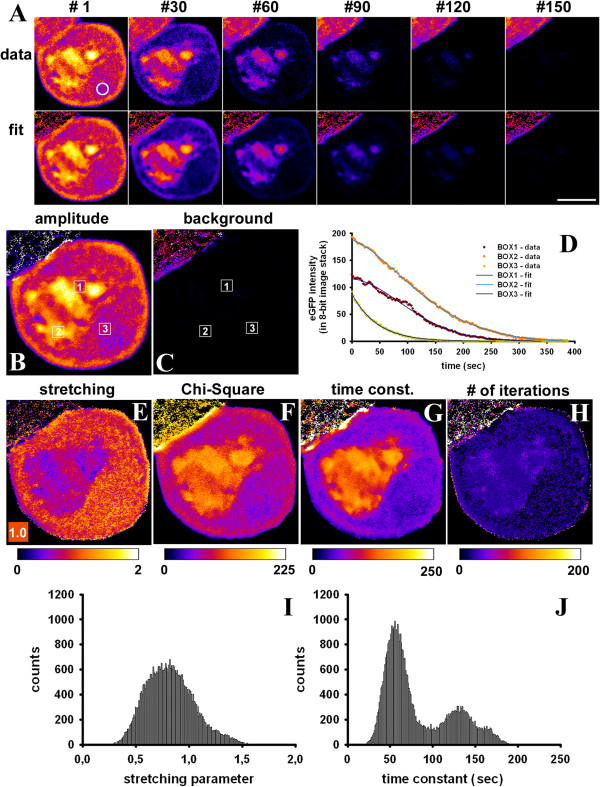
Barrier-limited FLIP of eGFP shuttling between nucleus and cytoplasm. McArdle RH7777 cells expressing eGFP in the cytoplasm and nucleus were placed on a temperature-controlled stage of a confocal microscope maintained at 35 ± 1°C. A 30 pixel diameter circular region in the cytoplasm (white circle) was repeatedly bleached with full laser power, while the whole field was scanned with 0.5% laser output between the bleach scans such that the total frame rate was 2.6 sec. A montage of every 30th frame of the data (upper panel, ‘data’) or of the reconstruction from a pixel-wise fit of data to the StrExp function (lower panel, ‘fit’). B, amplitude map; C, background map, each with three boxes numbered 1 to 3. D, FL in these three boxes along the stack (colored symbols) + fit to StrExp function (colored lines). E-H, parameter maps produced by PixBleach for: E, the stretching parameter (see Eq. 1; the color code for h = 1, the mono-exponential case, is given in small box); F, χ2-values showing the quality of the regression; G, time constant map; H, number of iterations. All values are color-coded using a FIRE-LUT, and the range is given below the images with a color bar. The time constant is given in seconds; all other values are without units. I, J; histograms of the stretching parameters (I) and the time constants (J) for the cell, shown in A-H. Bar, 5 μm.